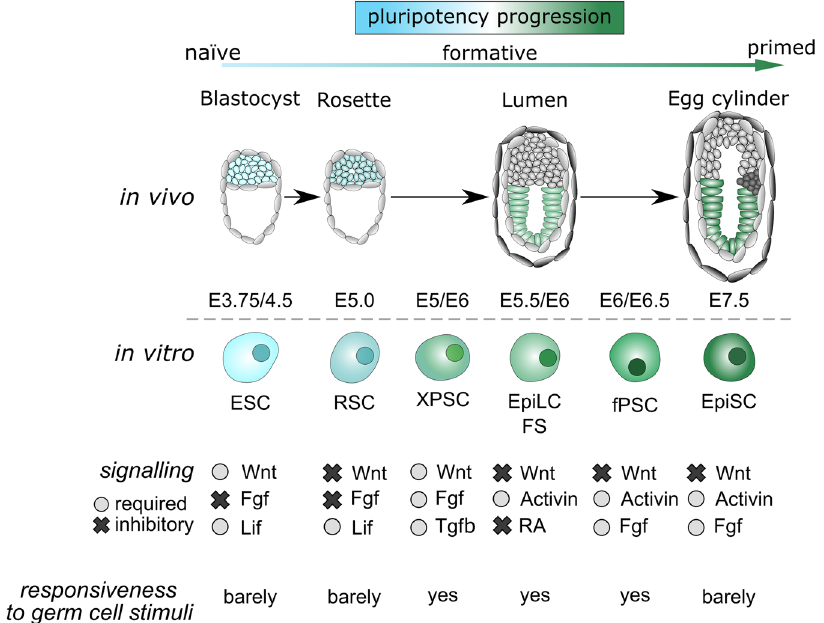
Fig. 1 | A continuum of transitional states de fi nes pluripotency progression. inductive signals. ESC: Embryonic Stem Cell, RSC: Rosette Stem Cells 13 , XPSC: X Pluripotent Stem Cells 15 , EpiLC: Epiblast-like Cells 12 , FS: Formative Stem cells 137 , fPSC: Formative Pluripotent Stem Cells 16 , EpiSC: Epiblast Stem